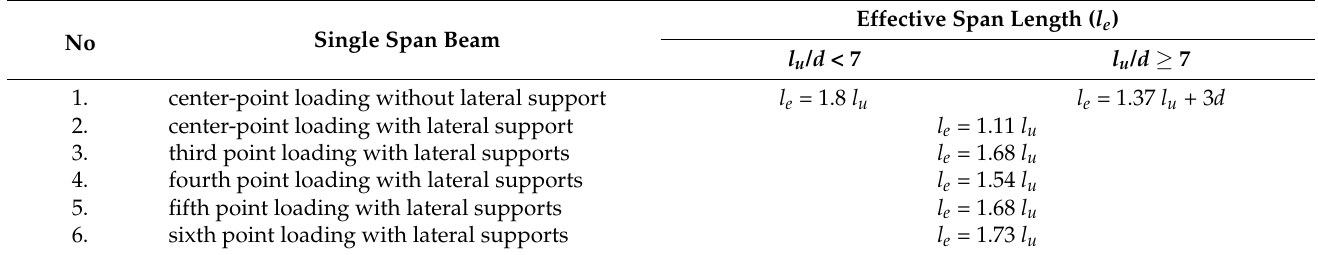
Table 2. Effective span length ( l e ) for bending